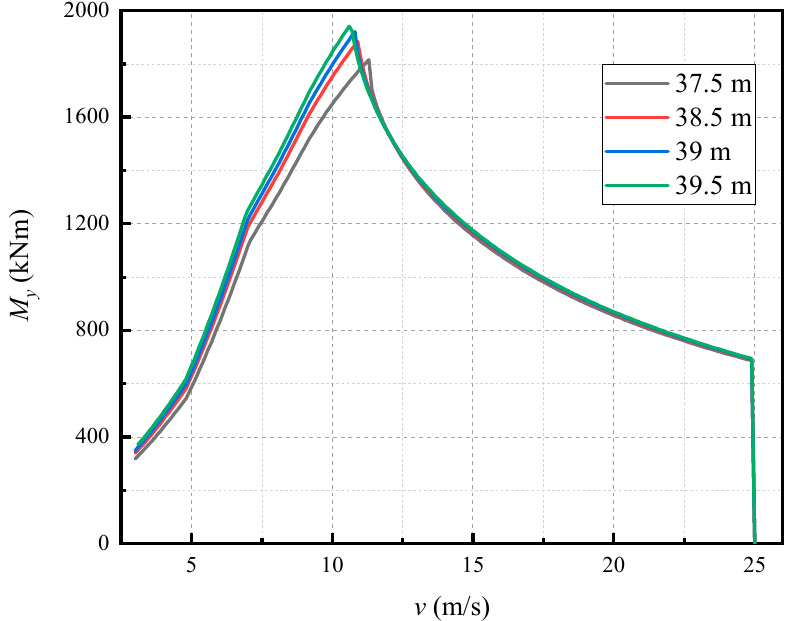
Figure 8. Bending moment of the blade root for turbines with different blade lengths. Table 5. Comparison of the steady loads of wind turbines with different blade lengths.